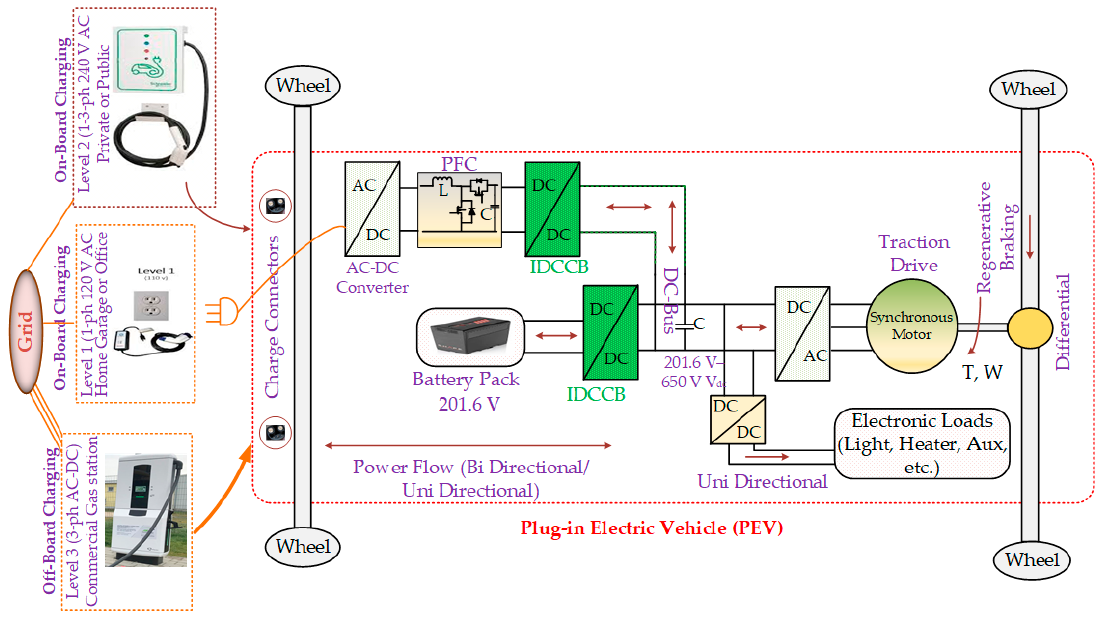
Figure 1. Architecture of a plug-in electric vehicle.